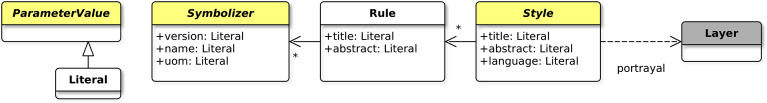
Recommendation for a minimal symbology core.